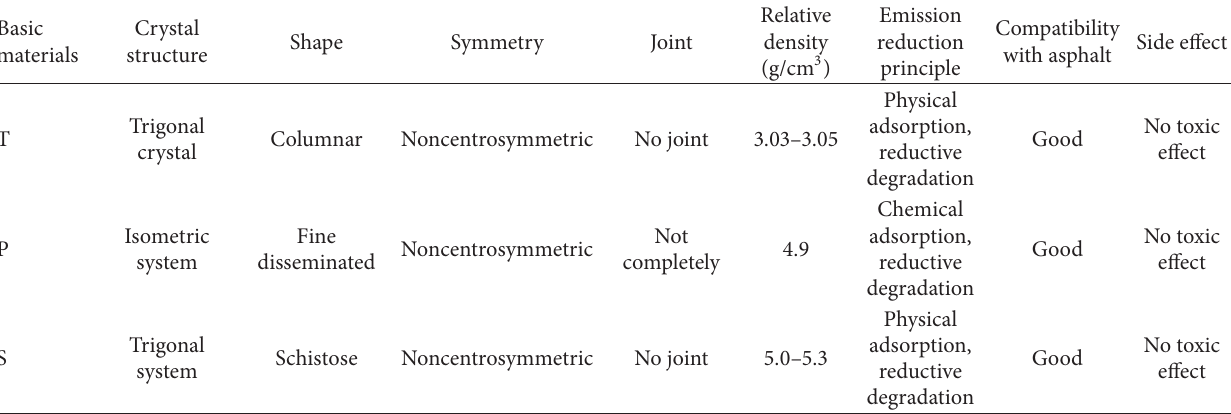
Table 1: Characteristics of basic materials.